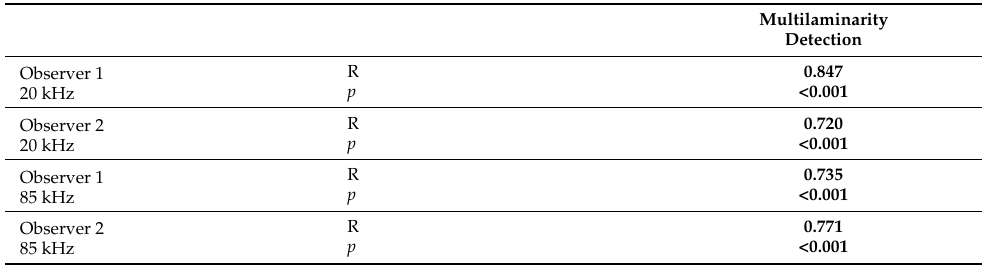
Table 6. Spearman’s correlation index (R) between the qualitative assessment of each observer and the multilaminarity detection of the same observer both to the 20 kHz images and to the 85 kHz. The bold values are statistically siginificative ( p <